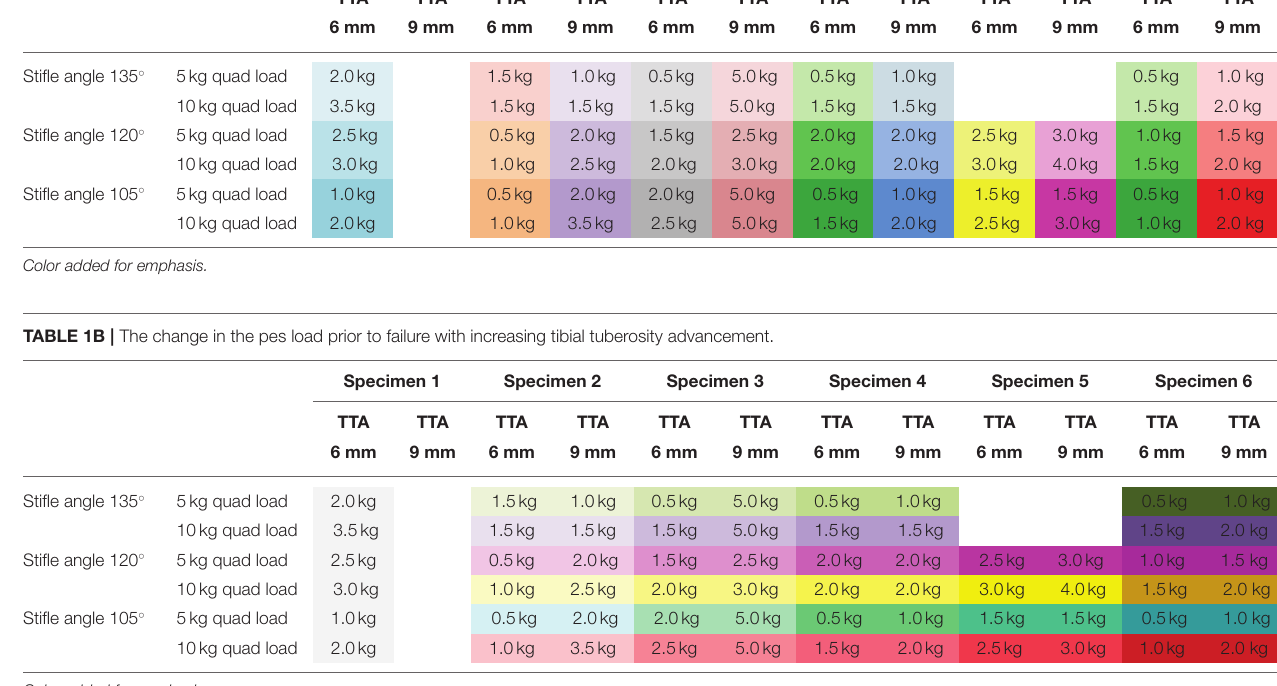
TABLE 1A | The change in the pes load prior to failure with increasing quadriceps load applied to the patella.